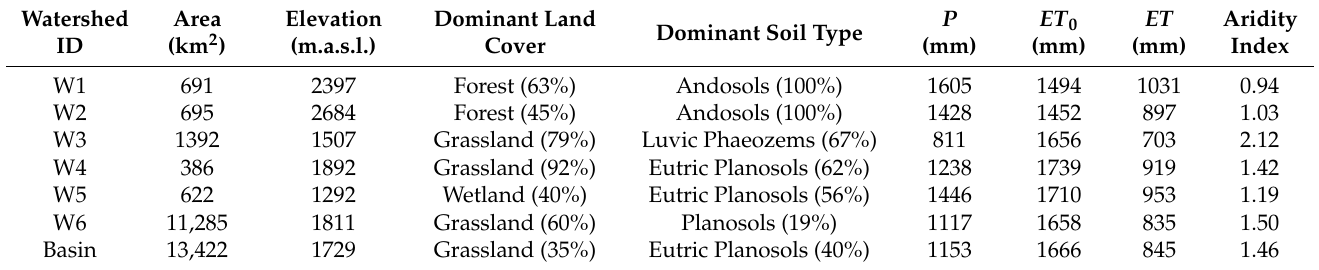
Table 1. Summary of selected watershed characteristics. P, ET 0 and ET represent mean annual (2002 – 2009) rainfall and reference and actual evapotranspiration, respectively. See their location in Figure 2 and note that W1 and W6 are watersheds with gauging stations.